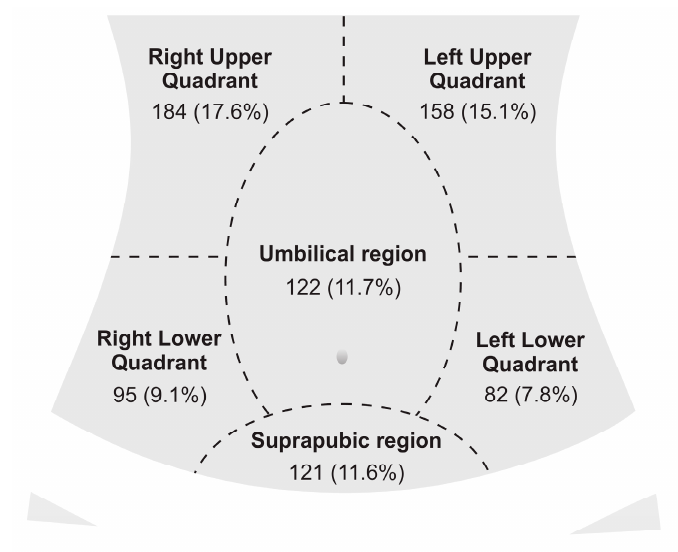
Figure 1. Location of the abdominal pain declared on a gastroenterology forum for anonymous